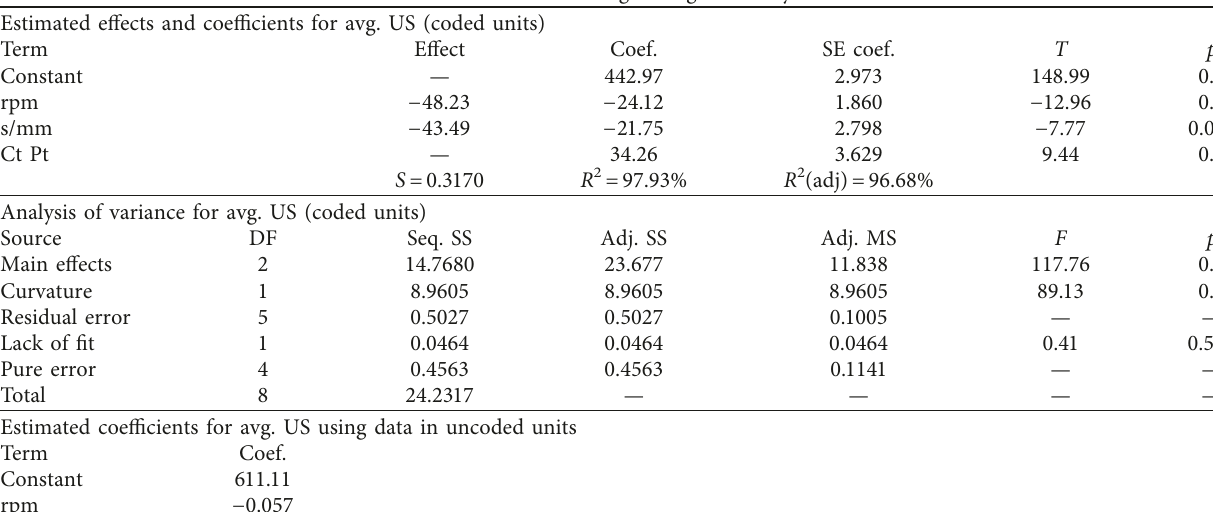
— — — — Table 7: Results of ultimate strength weighted analysis of